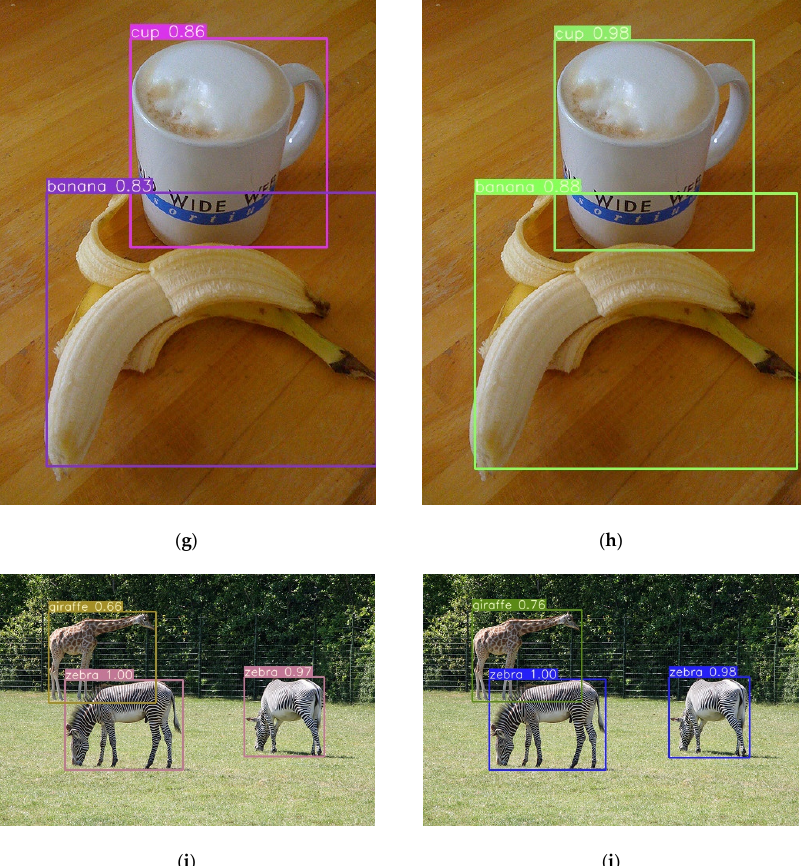
Figure 3. Object detection results using the YOLOv3 method (subfigures ( a ) 、 ( c ) 、 ( e ) 、 ( g ) and ( i ), and object detection results using our proposed method (subfigures ( b ) 、 ( d ) 、 ( f ) 、 ( h )and ( j )).